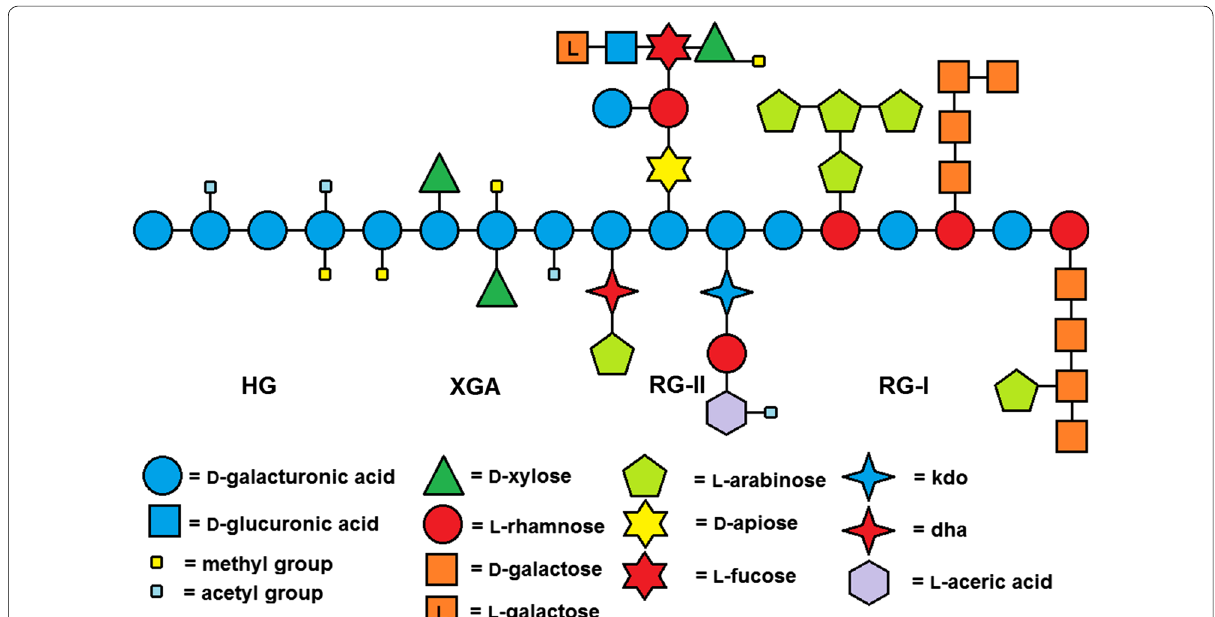
Fig. 1 Structure of the pectic polymers homogalacturonan (HG), xylogalacturonan (XGA) rhamnogalacturonan II (RG-II) and rhamnogalacturonan I (RG-I). Figure from (Kuivanen